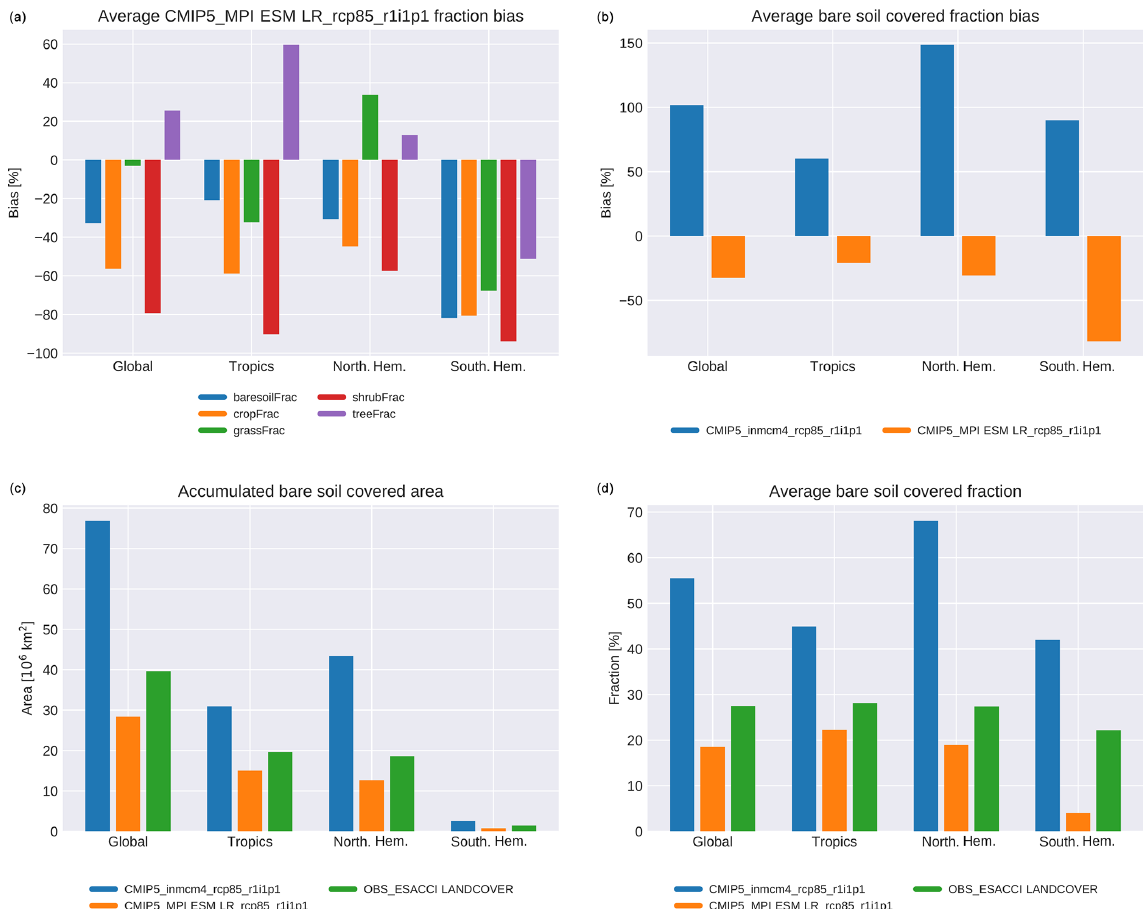
Figure 33. The panels show plots produced by the metric recipe_landcover.yml using model output from historical CMIP5 simulations (period 2008–2012) of the ESMs MPI-ESM and INMCM4 compared to land cover observations provided by ESA CCI for different regions. Panels (a, b) display the relative bias (%) between the models M and the observation O computed as (M − O)/O × 100. This can be visualized either for one model (i.e. MPI-ESM) and several land cover types (a) or for one land cover type (i.e. bare soil fraction) and all selected models (b) . Panels (c, d) display the area (10 6 km 2 ) covered by a specific land cover type (i.e. bare soil fraction) for given regions (c) , as well as the average cover fractions (%) (d) with respect to the total area of the regions. Thus, the land cover analysis provides a quick overview for major land cover types and the ability of different models to reproduce them. The metric is based on the analysis presented in Lauer et al. (2017) and Georgievski and Hagemann (2018) and discussed in Sect.